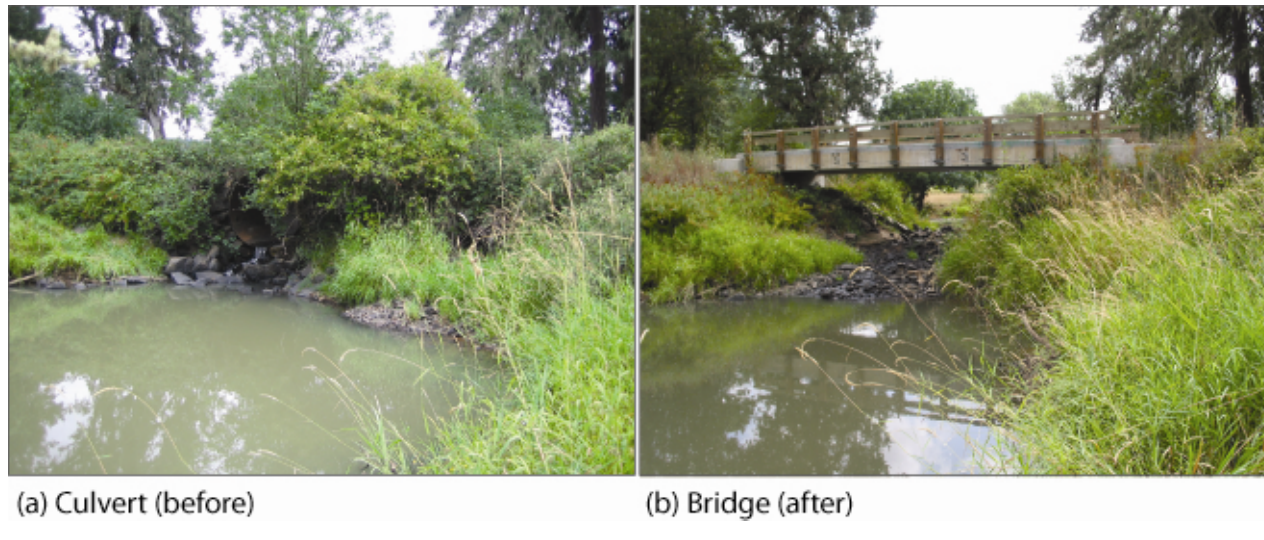
Fig. 6. Coyote Creek Culvert to Bridge Project. On Coyote Creek, a culvert-to-bridge project opened up cutthroat trout access into 74 km of upstream habitat (a and b). This site was identified through outreach to landowners with priority habitat locations found through the water-quality sampling program. This project developed into additional components that improved in-stream and riparian habitat conditions on a 160-ha ranch and is now an anchor demonstration project for a new subwatershed enhancement program in the Coyote Creek